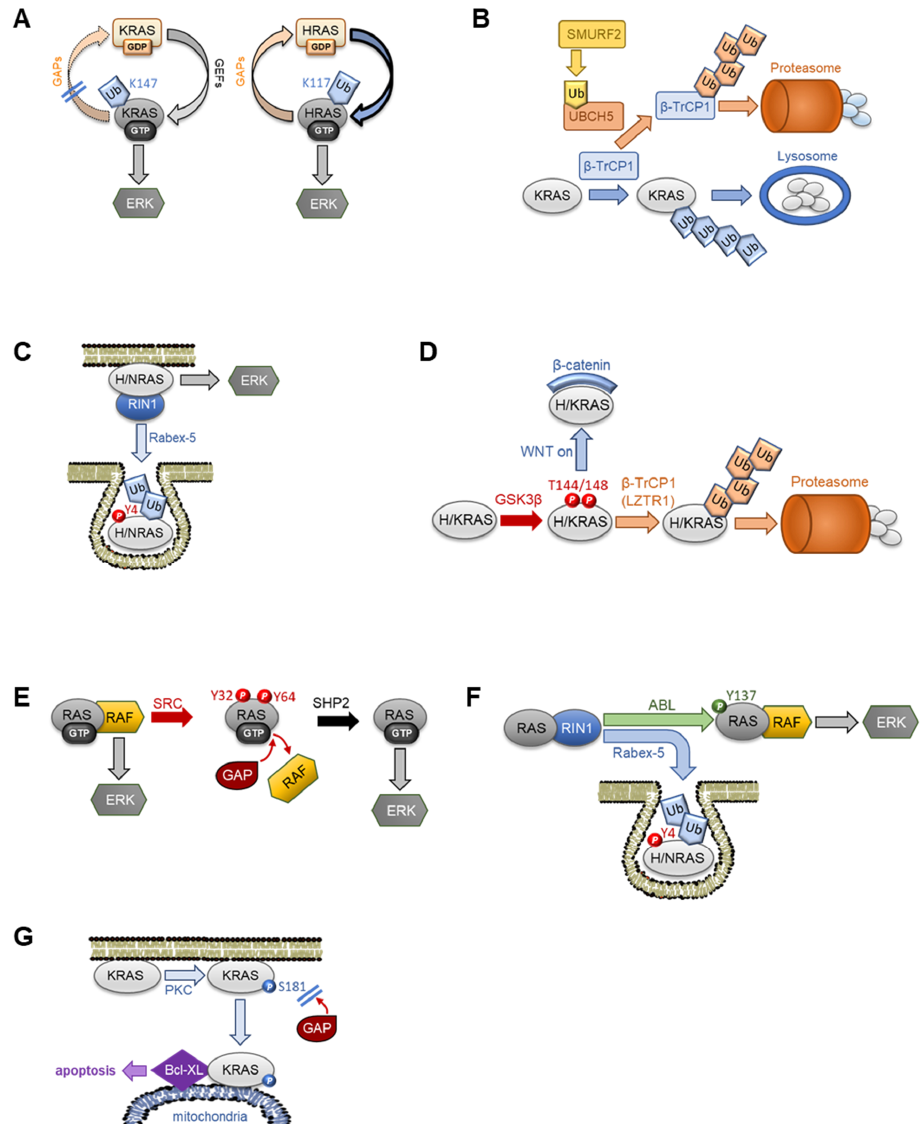
Figure 5. RAS regulation by posttranslational modifications. ( A ) RAS regulation by mono-ubiquitination. KRAS mono- ubiquitination at lysine 147 renders KRAS refractory to GAPs, while HRAS mono-ubiquitination at lysine 117 stimulates GEF independent GTP binding. Both mechanisms lead to the activation of downstream pathways such as ERK. ( B ) The constitutive lysosomal degradation of KRAS mediated by β -TrCP1 is impeded by Smurf2 mono-ubiquitinating UBCH5, which in turn poly ubiquinates β -TrCP1 and marks it for proteasomal degradation. ( C ) RAS regulation by mono-/di- ubiquitination. Rabex-5 can mono/di-ubiquitination NRAS and HRAS inducing endosomal localization and inability to activate ERK. ( D ) HRAS and KRAS degradation can be triggered by GSK3 β phosphorylation of threonines 144 and 148, which induces poly ubiquitination by β -TrCP1. When WNT signaling is activated, stabilized β -catenin can bind to KRAS and physically shield the threonines 144/148 from phosphorylation resulting in KRAS protein accumulation. ( E ) Negative RAS regulation by tyrosine phosphorylation. The SRC kinase can phosphorylate all three RAS isoforms at tyrosines 32 and 64 leading to inhibition of effector binding and enhancement of GAP binding. These phosphorylations can be reversed by the SHP-2 phosphatase, which can restore signaling. ( F ) The RIN1 effector stimulates ABL mediated phosphorylation of Y137 which promotes RAF kinase binding and activation of the ERK pathway. However, RIN1 also stimulates Rabex-5-dependent ubiquitination of RAS, which leads to its endosomal sequestration. This ubiquitination is facilitated by the phosphorylation of tyrosine 4 by an unknown kinase. ( G ) PKC phosphorylation of KRAS at S181 has two effects. It reduces the interaction with GAPs prolonging KRAS signaling and induces the translocation of KRAS to the mitochondria, where it can bind to Bcl-XL and induce